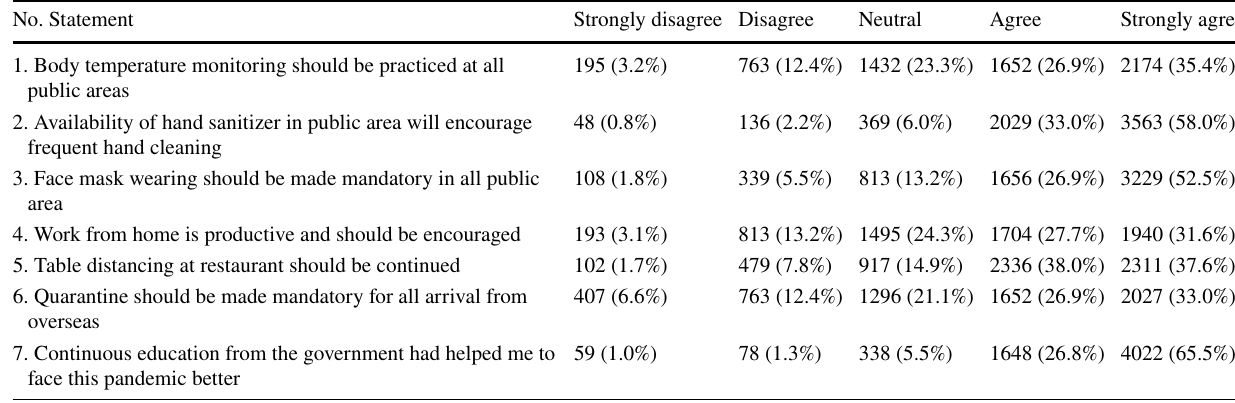
Table 8 Descriptive data of attitude towards new norm during the COVID-19 pandemic